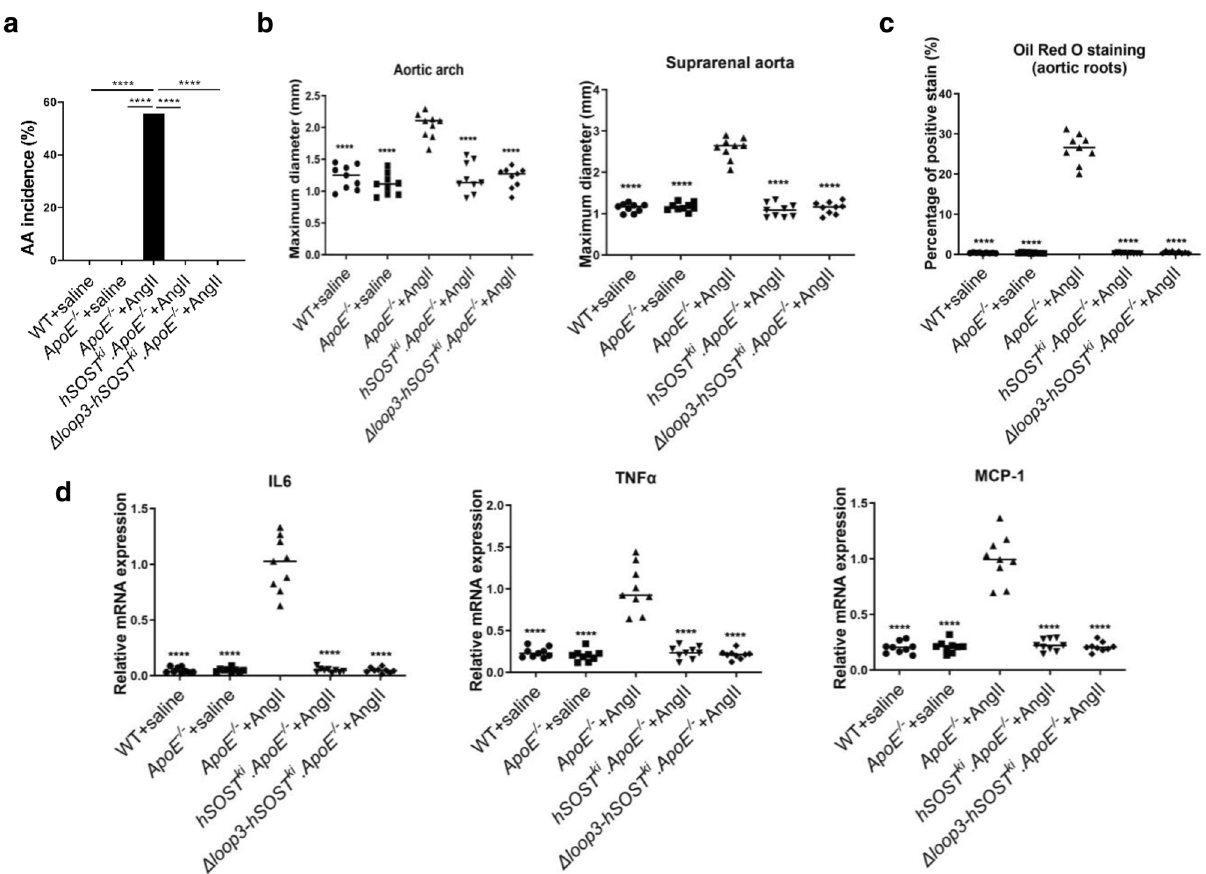
Fig. 2 Determination of whether loop3-de fi cient sclerostin by genetic truncation could maintain the protective effect of sclerostin on the cardiovascular system in ApoE − / − mice with loop3-de fi cient human sclerostin knock-in ( Δ loop3-SOST ki .ApoE − / − ). Comparisons were performed among wide-type mice with saline infusion (WT + saline), ApoE − / − mice with saline infusion ( ApoE − / − + saline), ApoE − / − mice with AngII infusion ( ApoE − / − + AngII), ApoE − / − mice with full-length human sclerostin knock-in and AngII infusion ( hSOST ki . ApoE − / − + AngII) and ApoE − / − mice with loop3- de fi cient human sclerostin (1-110) knock-in and AngII infusion ( Δ loop3-SOST ki .ApoE − / − + AngII). a The incidence of AA formation. A two-sided chi-square test was performed to determine the difference between two groups. **** p < 0.0001. p < 0.0001 for all comparisons. b Ex vivo measurement of the maximum diameters of the aortic arches (left) and suprarenal aortas (right). Aortic arch: p < 0.0001 for all grou p s; suprarenal aortas: p < 0.0001 for all groups. c Quanti fi cation of positive Oil Red O staining per cryosection indicating the ratio of atherosclerotic plaque area to total cross cryosection area (%) of the aortic roots. p < 0.0001 for all groups. d Serum levels of in fl ammatory cytokines (IL-6, TNF- α ) and chemokines (MCP-1). IL-6: p < 0.0001 for all groups; TNF- α : p < 0.0001 for all grou p s; MCP-1: p < 0.0001 for all groups. For ( b to e ), data were expressed as the mean ± standard deviation. n = 9 per group. One-way ANOVA with Tukey ’ s post-hoc test vs. ApoE − / − + AngII was used to determine the intergroup differences. **** p < 0.0001. Note: AA: aortic aneurysm; AngII: angiotensin II; IL-6: interleukin 6; MCP-1: monocyte chemoattractant protein-1; TNF- α : tumour necrosis factor alpha. Source data are provided as a Source Data fi